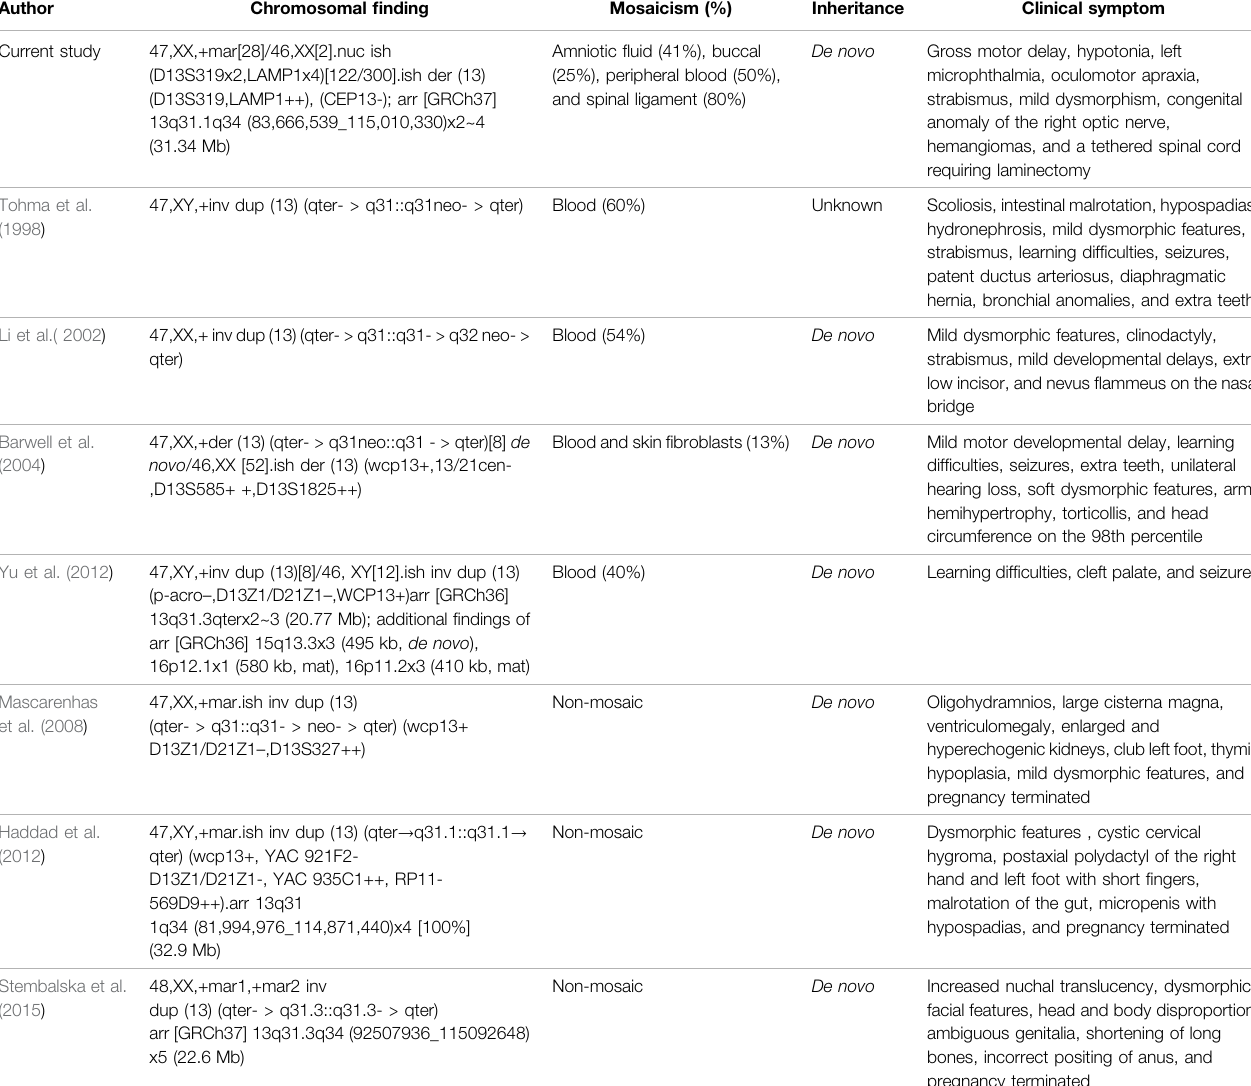
TABLE 2 | Summary of chromosomal fi ndings, degree of mosaicism, inheritance, and clinical symptoms in the current proband and previously reported sSMC cases with breakpoints in 13q31.